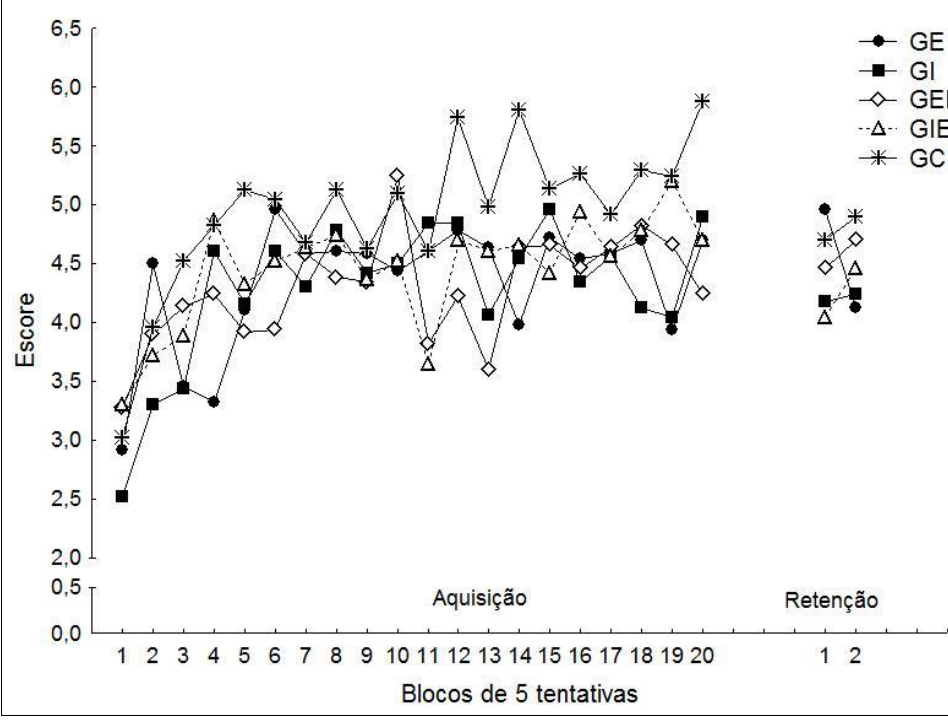
Figura 2. Média do escore dos grupos na fase de aquisição e teste de retenção.